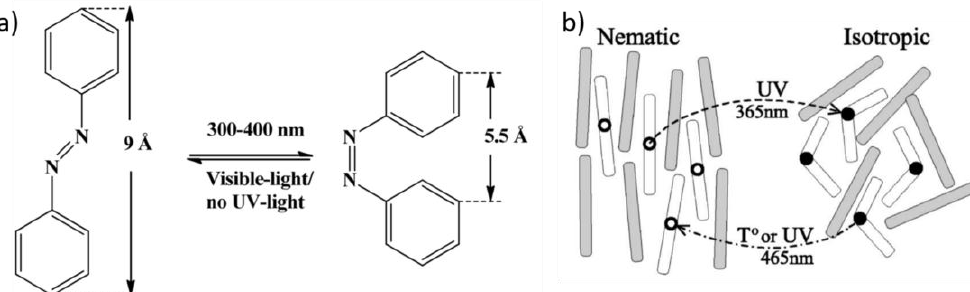
Figure 5. ( a ) The trans - cis isomerization of azobenzene, reprinted with permission from Reference [63]. Copyright 2013, MDPI Materials; ( b ) schematic depiction of nematic-isotropic phase transformation in a LC containing photo-isomerizable mesogenic molecules, which turn from a rod-like trans to a kinked cis conformation under ultraviolet (UV) irradiation. Reprinted with permission from Reference [64]. Copyright 2002 , APS Physical Reviews E.